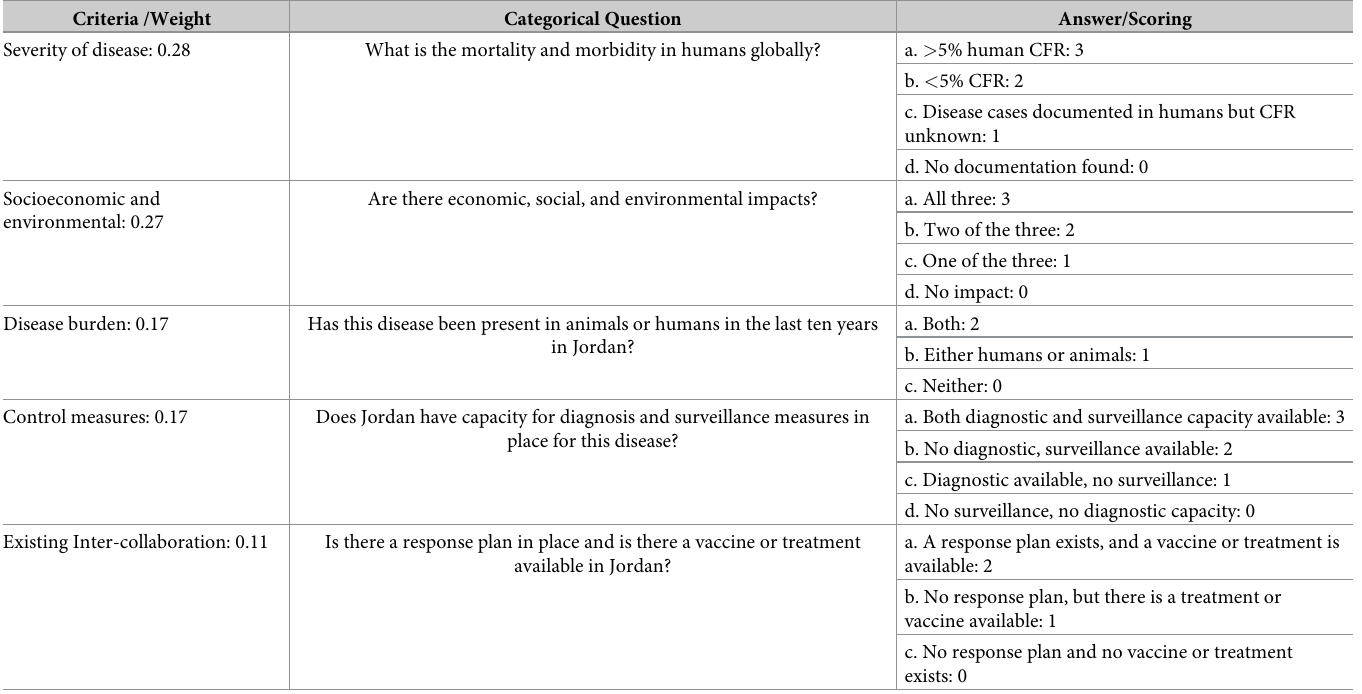
Table 5. Modified zoonotic disease prioritization tool to be used for Jordan. Criteria